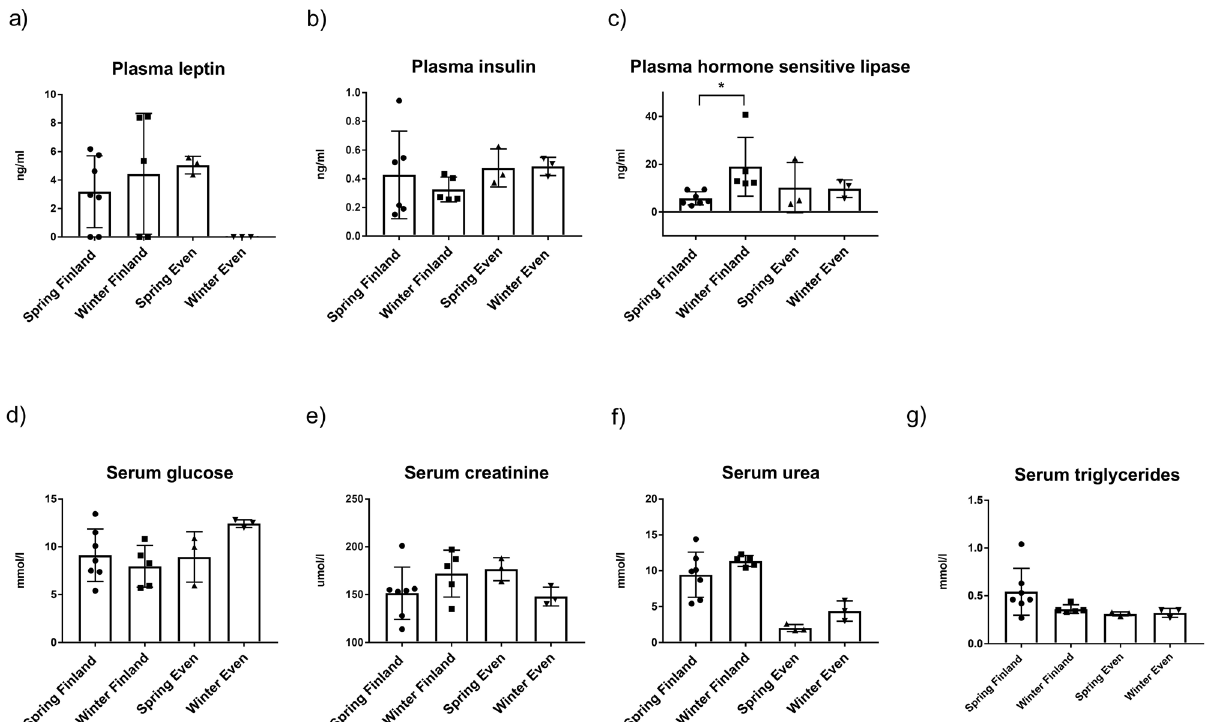
Fig. 6 Plasma hormone and serum metabolite levels in Finnish male reindeer in winter ( n = 5) and spring ( n = 7) and in male Even reindeer in winter ( n = 3) and spring ( n = 3). Plasma hormones a leptin, b insulin, and c hormone-sensitive lipase (HSL) and serum metabolites d glucose, e creatinine, f urea, and g triglyceride levels are presented as mean ± SD. Signi fi cant difference between seasons is indicated with a bar and an asterisk (* p ≤